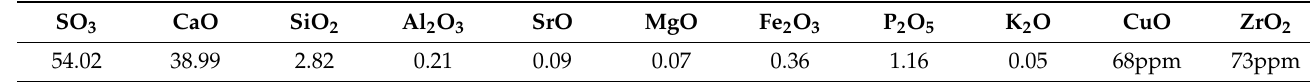
Table 1. The chemical composition of PBG.